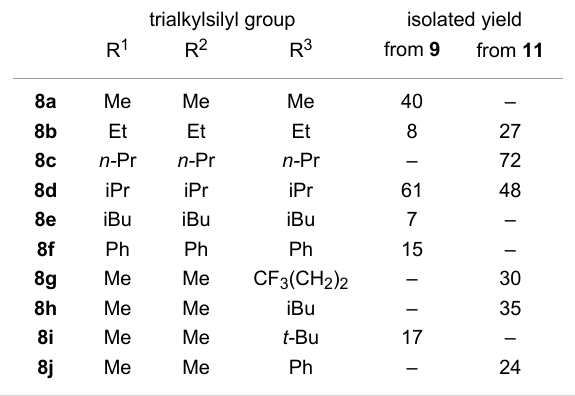
Table 1: Diethynyl-IF-diones synthesized and yields for Sonogashira cross-coupling. trialkylsilyl group isolated